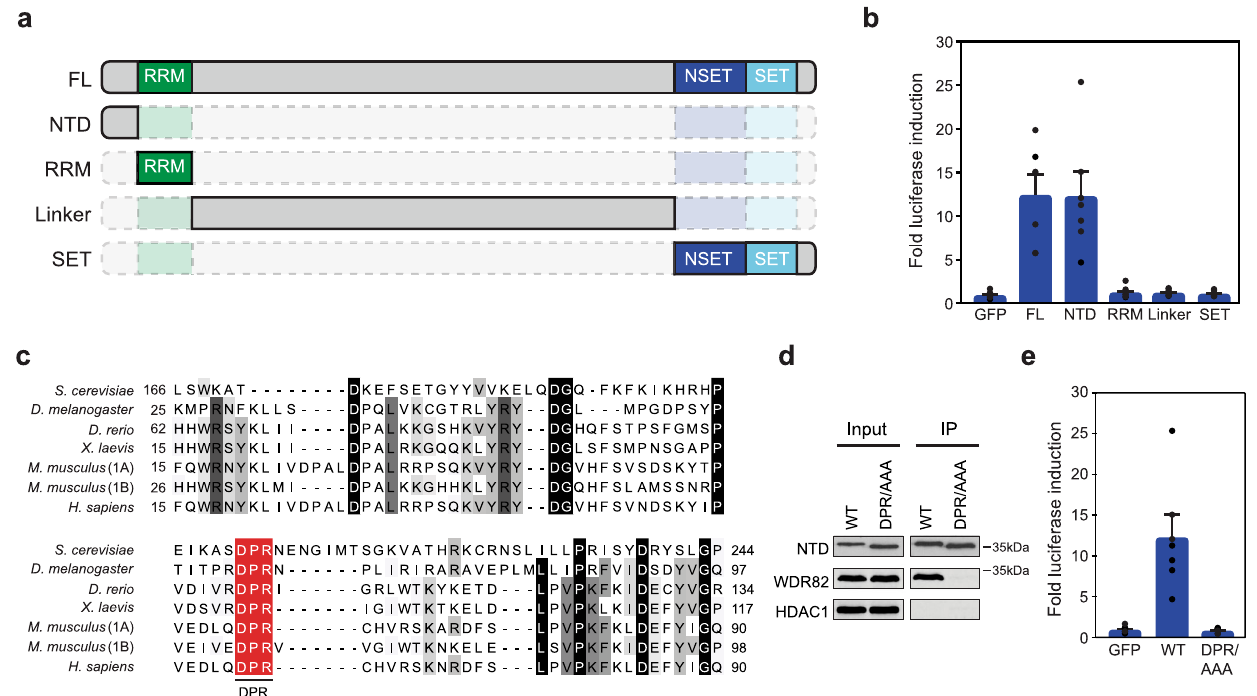
Fig. 3 | SET1 complexes support gene expression through an interaction with WDR82. a A schematic illustrating the SET1A domains that were tethered to the reporter gene. b A bar plot showing the mean fold induction of reporter gene expressionfollowingtetheringoftheGFP,fulllengthSET1A(FL),NTD,RRM,Linker, and the NSET-SET (SET) domain fragments to the reporter gene. Error bars repre- sent SEM from seven biological replicates. c A multiple sequence alignment of the N-terminaldomainsofSET1A(1A)orSET1B(1B)fromtheindicatedspecies.Thered